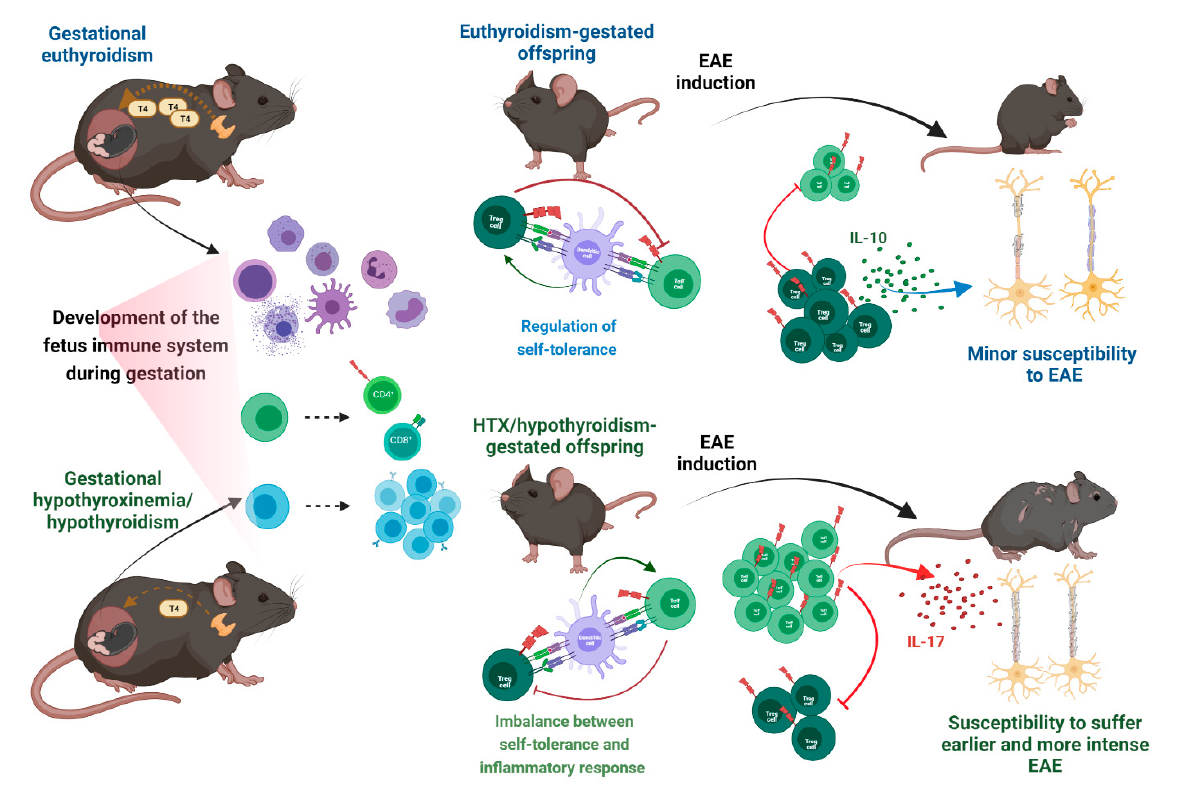
Figure 3. Thyroid hormone deficiency during gestation increases the immune response of the offspring after EAE induction. During the period of gestation, development and migration of immune cells usually occur properly; however, when it takes place under conditions of THs deficiency, this developmental process is altered. The offspring gestated in HTX, or hypothyroidism that was challenged with EAE in adulthood, have an early and severe disease onset that involves a more significant deterioration of the myelin sheath compared to progeny gestated in euthyroidism, which have lower susceptibility to suffering from the disease with less deterioration of the myelin sheath. Furthermore, HTX–Treg lymphocytes have a reduced suppressive capacity and a lower secretion of IL-10, establishing an imbalance of self-tolerance, compared with progeny gestated under euthyroid conditions who have Treg lymphocytes capable of exerting the suppressive effect correctly. Created with BioRender.com (accessed on 1 Jan 2022).